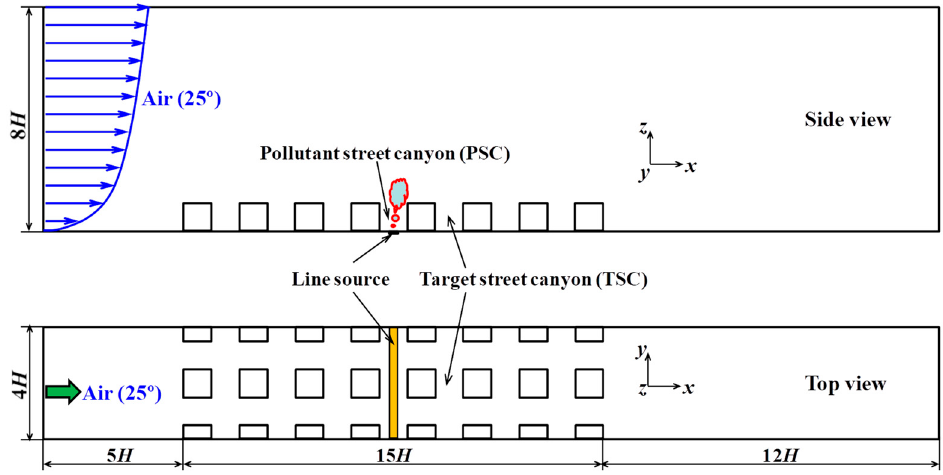
Figure 4. Computational domain and setup of the simulation.